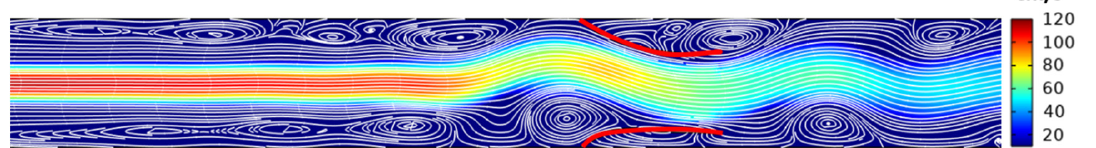
Figure 7. Asymmetric bending of valve leaflets (red) by vortices in the model D (with 75% up- stream stenosis).